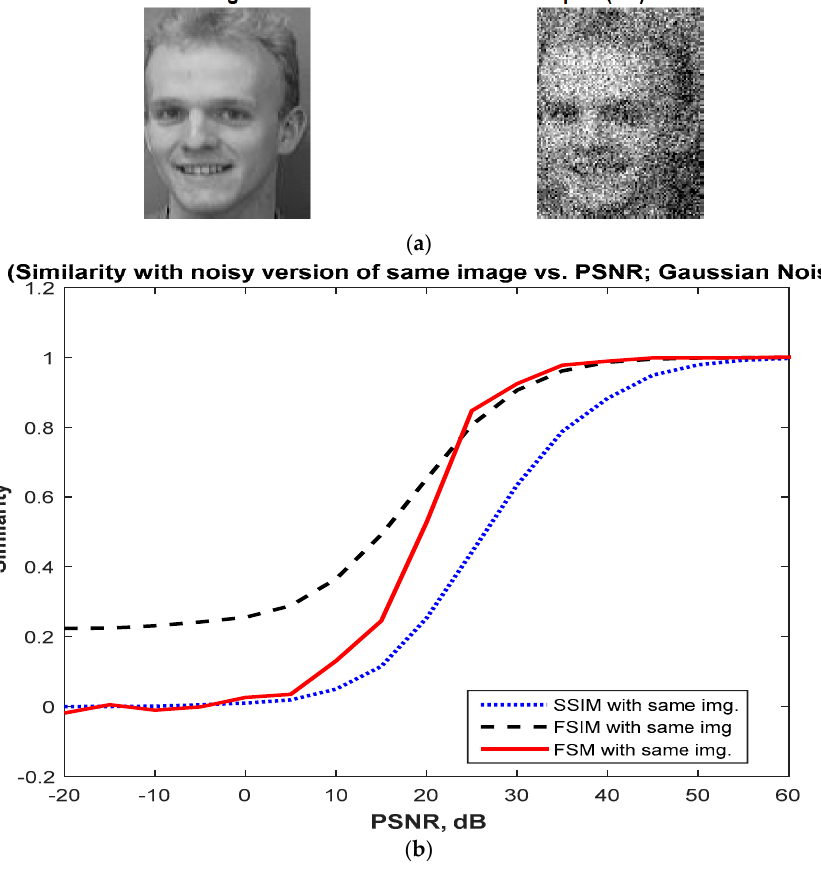
Figure 16. Performance of similarity measures using similar images under Gaussian noise; ( a ) The test images; ( b ) Performance comparison among (SSIM, FSM and FSIM) under Gaussian noise.